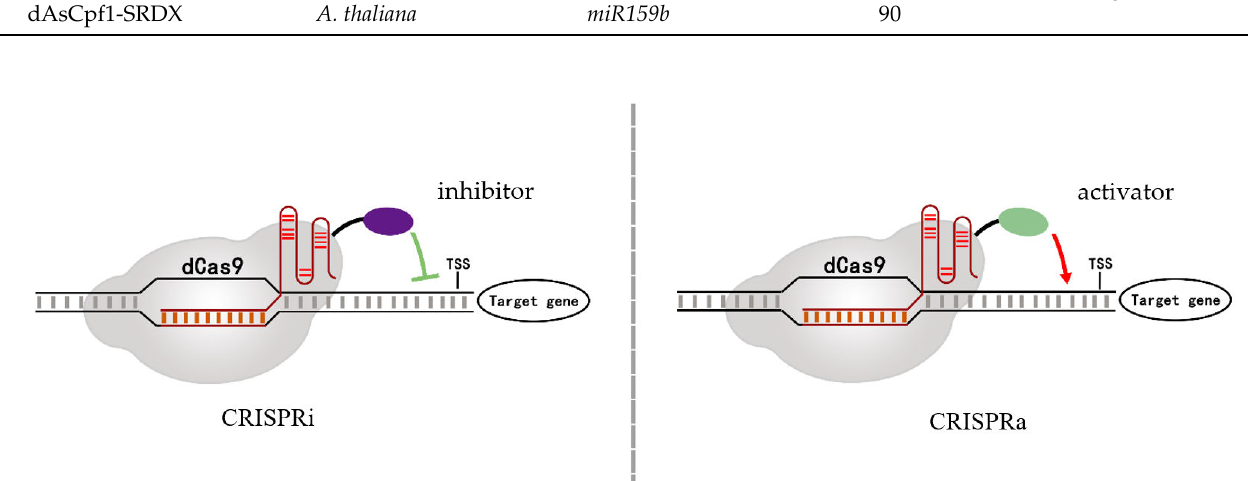
Figure 2. The diagram of CRISPR/dCas9-mediated transcriptional regulation. The dCas9 fused with transcriptional inhibitors or activators can provide additional inhibition (CRISPRi) or activation (CRISPRa)